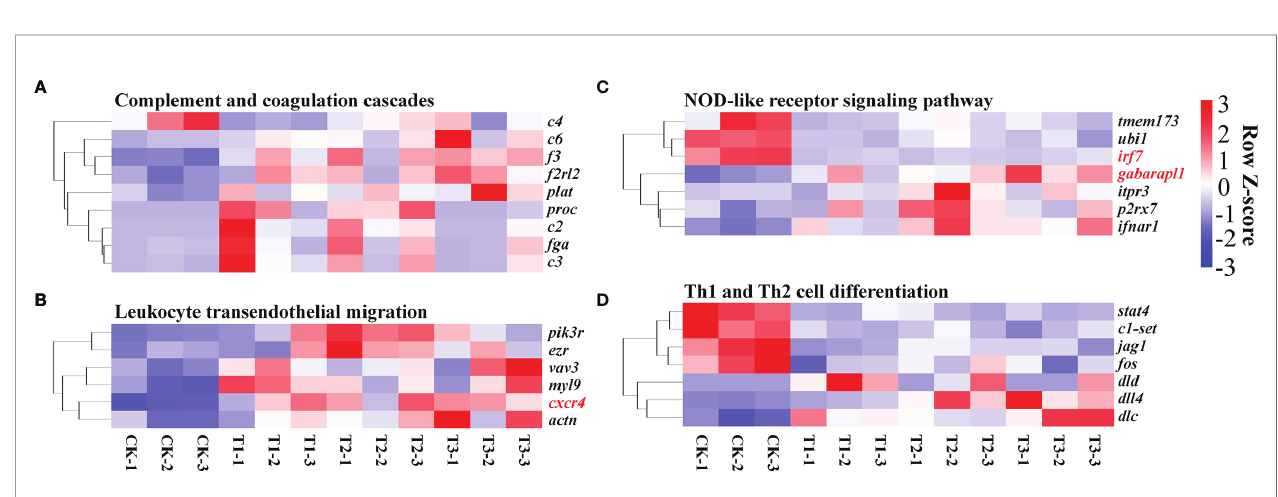
FIGURE 7 | Heat map exhibiting alterations in gene expression in the pathways related to immune response, like complement and coagulation cascades (A) , leukocyte transendothelial migration (B) , NOD-like receptor signaling cascade (C) , and Th1 and Th2 cell differentiation (D) . The evaluation criteria used the average RPKM value per gene. Genes with contents greater than the mean are colored red, while those with contents below the mean are colored